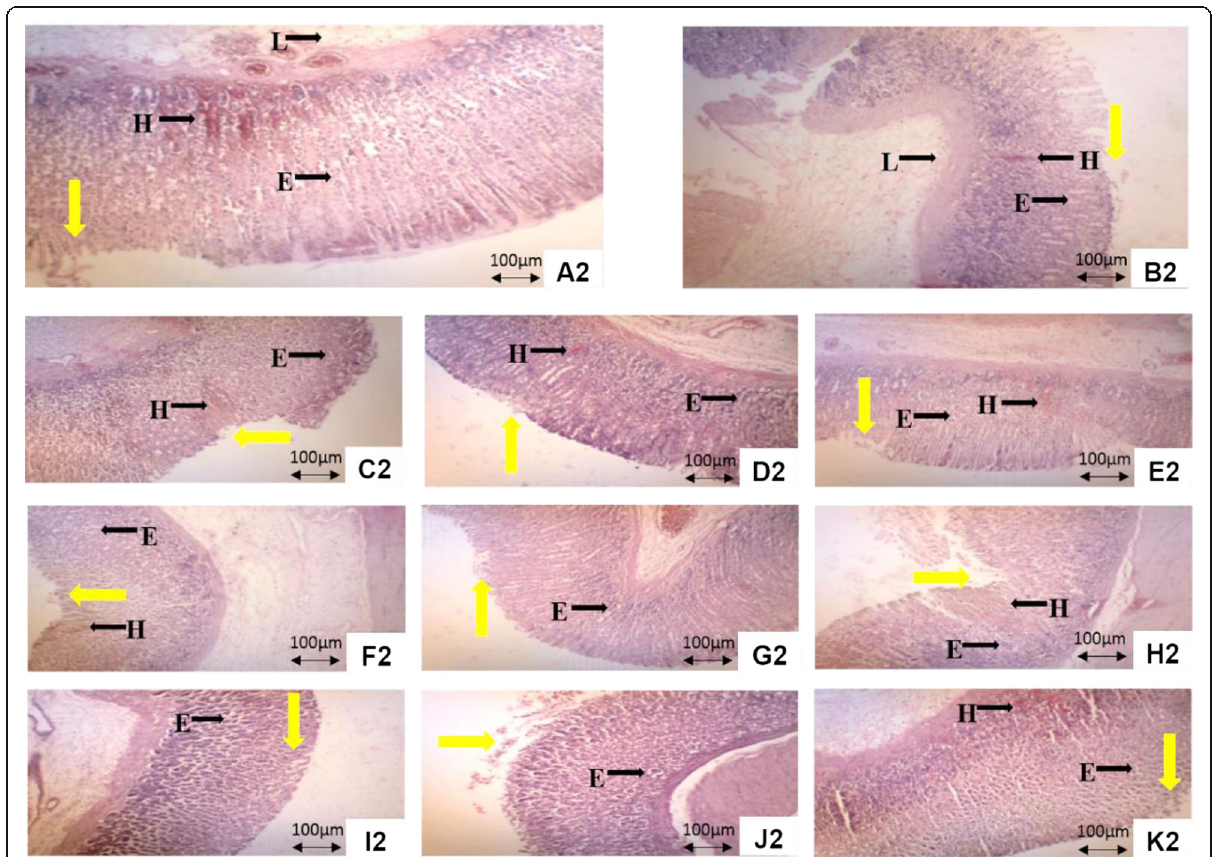
Fig. 4 Histological evaluation of the ethanol intoxicated gastric mucosa tissue of rats orally pretreated with various test solutions. (A2) Rats pretreated with 2% Tween 80 (ulcer control) showing severe destruction to surface epithelium and necrotic lesions. (B2) Rats pretreated with ranitidine (100 mg/kg, positive control). Moderate disruption to gastric mucosa layer with moderate edema and hemorrhage, in addition of leukocyte infiltration was observed. (C2, D2, E2) Stomach receiving low dose of 1:1, 1:3 and 3:1 MMMC, respectively (15 mg/kg). Mild lesion on mucosa was seen in group C2 with mild hemorrhage and edema. Meanwhile, in group D2 and E2 show a very moderate effect on mucosa with mild hemorrhage and edema. (F2, G2, H2) Stomach pretreated with 150 mg/kg of 1:1, 1:3 and 3:1 MMMC respectively. Mild effect on mucosa and edema were formed in group F2 and G2. Group H2 exhibit very moderate lesion and mild edema and hemorrhage. (I2, J2, K2) Stomach pretreated with 300 mg/kg of 1:1, 1:3 and 3:1 MMMC with group K2 showing a moderate effect on mucosa with moderate hemorrhage and mild edema. Group I2 exhibit very mild effect mucosa with edema indicating that the 1:1 MMMC at its highest dose was highly able to protect the gastric mucosa. The yellow arrow indicates disruption to the surface epithelium. H-hemorrhage; E-edema; L-leukocyte